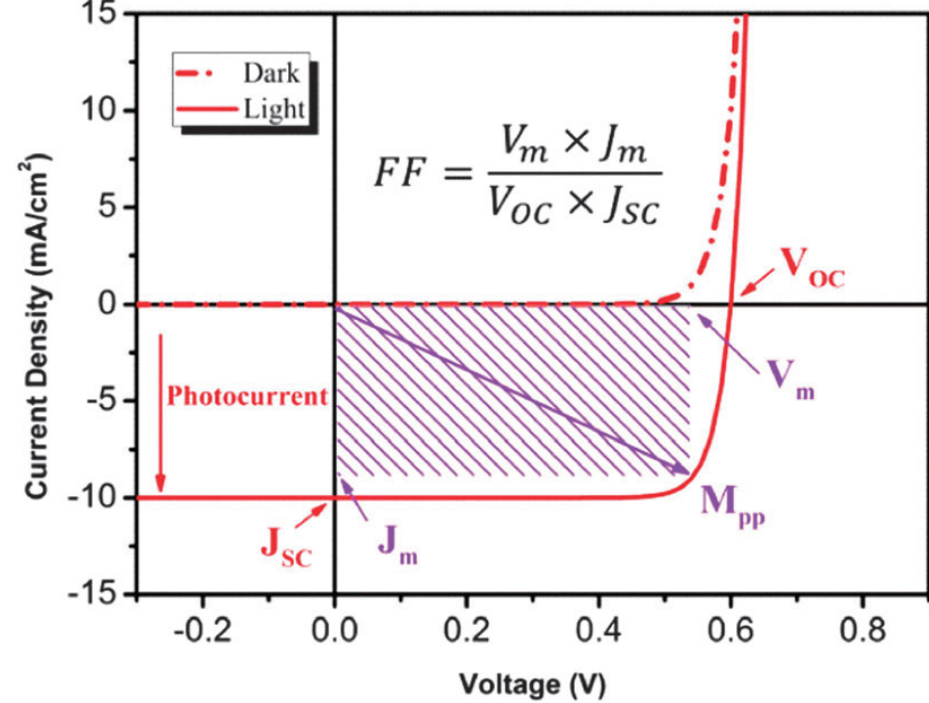
Figure 3. Typical current-voltage (I-V) characteristics for dark and light current in a solar cell, illus- trating the important parameters for such devices. J SC is short-circuit current density, V OC is open- circuit voltage, J m and V m are the current density and voltage at the maximum power point (Mpp), and FF is the fill factor. Reprinted with permission from ref. [17]. Copyright 2013 Royal Society of Chemistry.